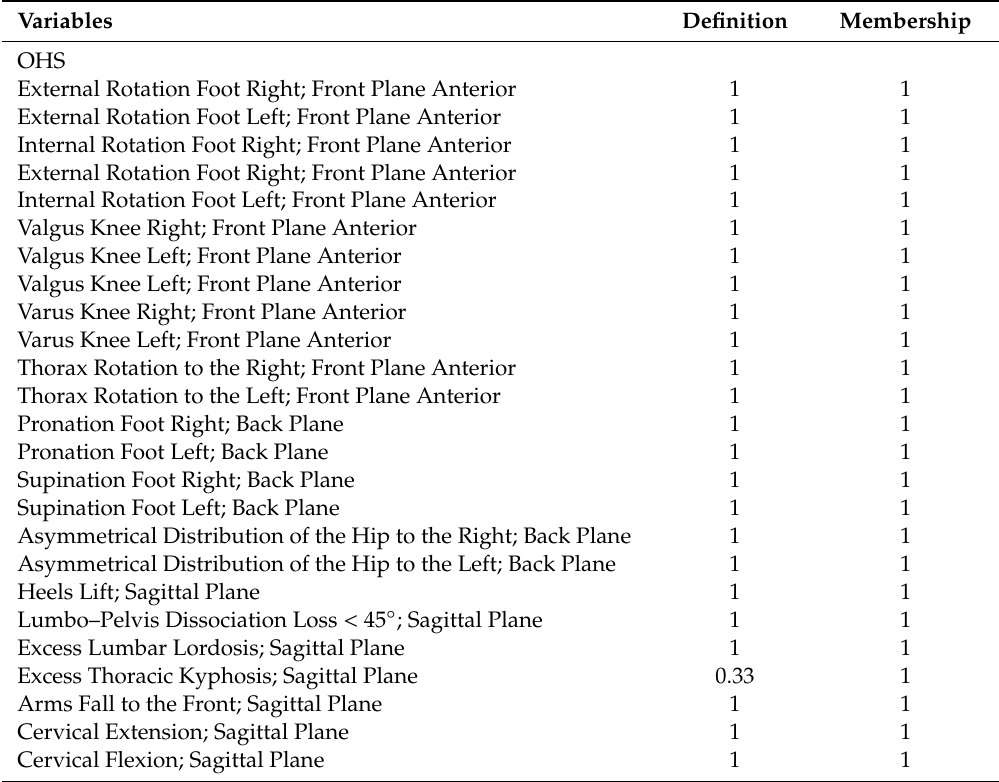
Table 3. Assessment of Aiken V by ten experts of the proposed variables for OHS.